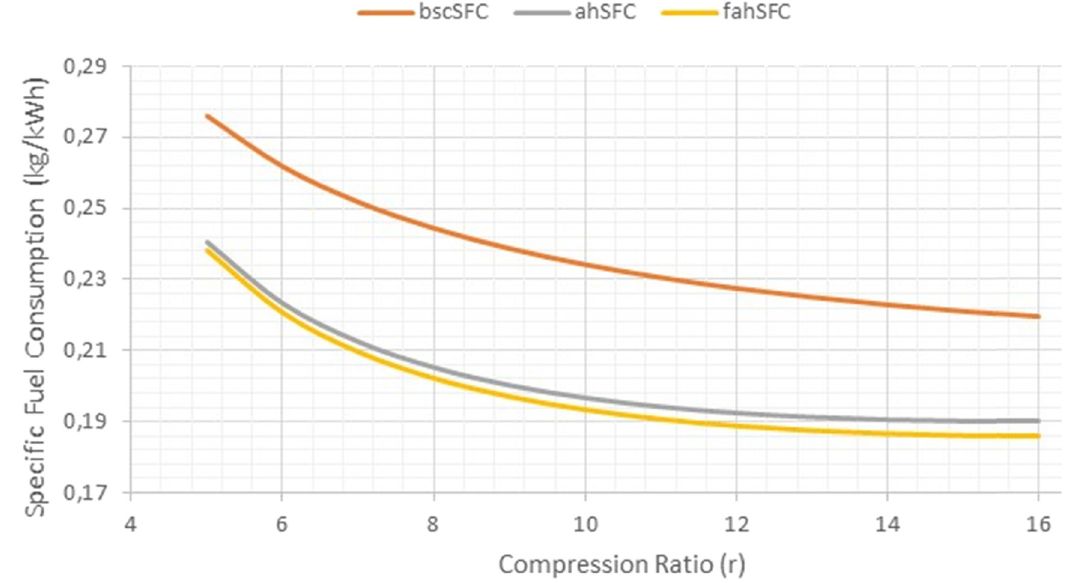
Figure 7: Variation of the SFC with the compression ratio ( r ) for bsc, ah and fah cogeneration systems.